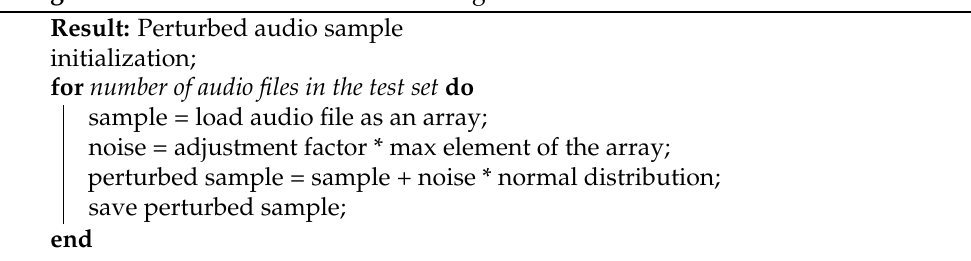
Algorithm 1: White Noise Generation Algorithm